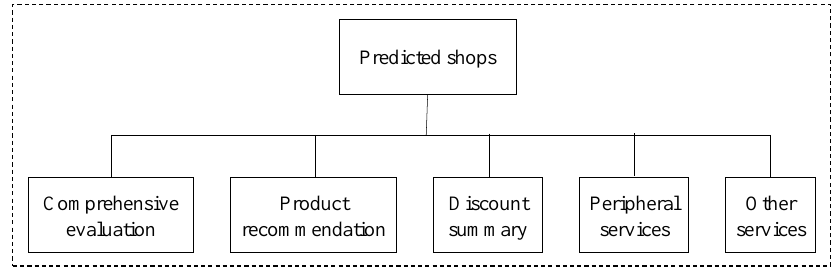
Figure 7. Services provided to customers using the predicted